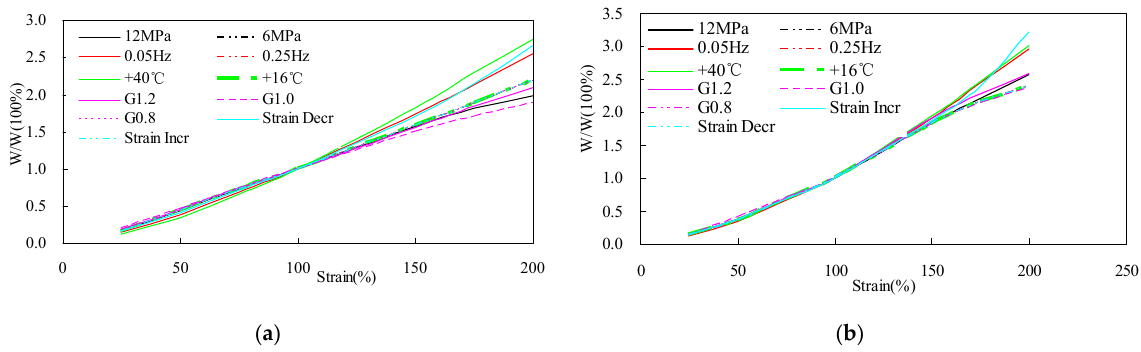
there are few changes from 6 to 12 Mpa or from the G value of 0.8 to 1.0 MPa and 1.2 MPa.